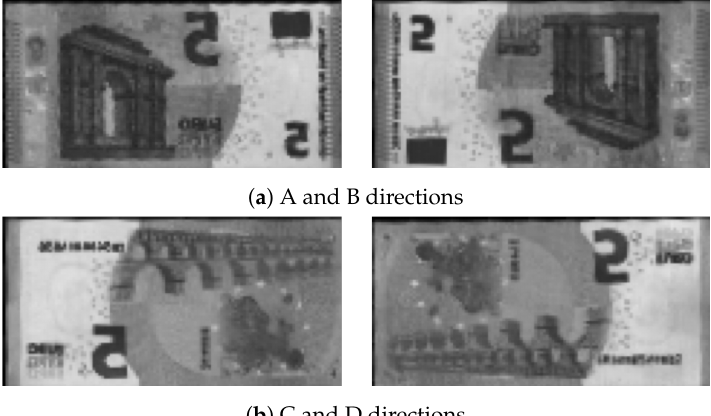
Figure 2. Possible banknote